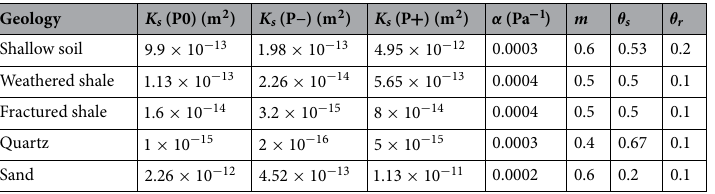
Table 1. Permeability values ( K s ) and van Genuchten soil parameters of the investigated model variations for the geological layers in